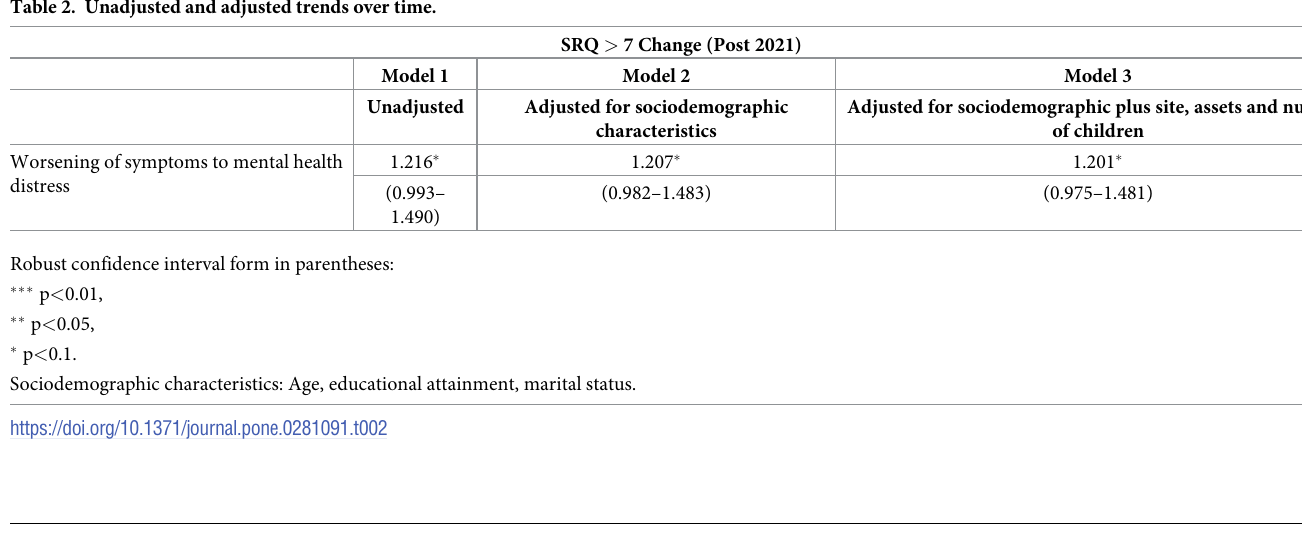
Table 2. Unadjusted and adjusted trends over